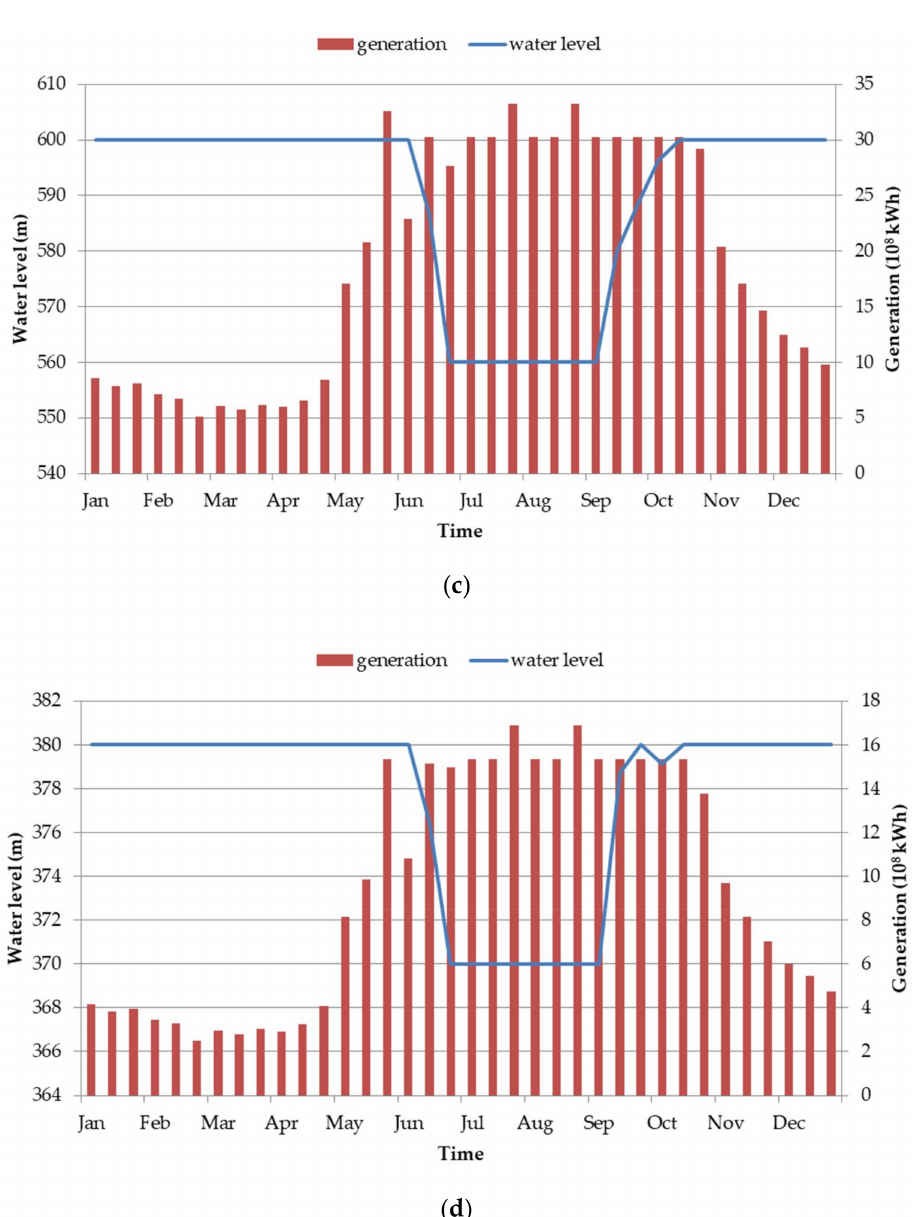
Figure 8. The optimal results obtained by GCS in wet years: ( a ) Wudongde; ( b ) Baihetan; ( c ) Xiluodu; and ( d )